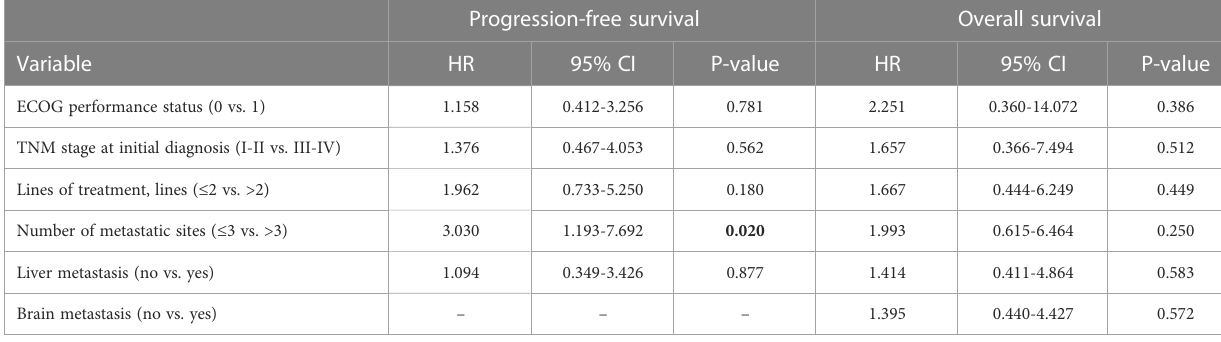
TABLE 5 Cox multivariate regression analysis for progression-free survival and overall survival. Progression-free survival Overall survival Variable HR 95% CI P ‐ value HR 95% CI P ‐